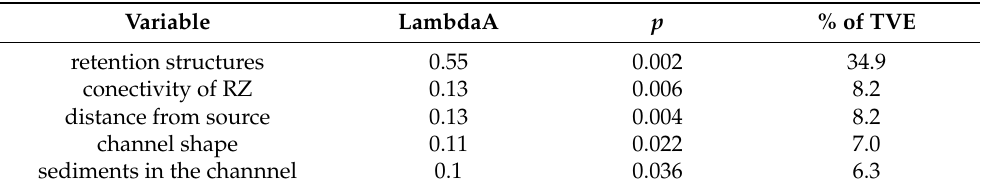
Table 3. Results of canonical correspondence analysis (CCA) parameters between diversity of macrophytes and assessed parameters. Only parameters that significantly influenced the distribution of macrophytes are listed (TVE—total variance